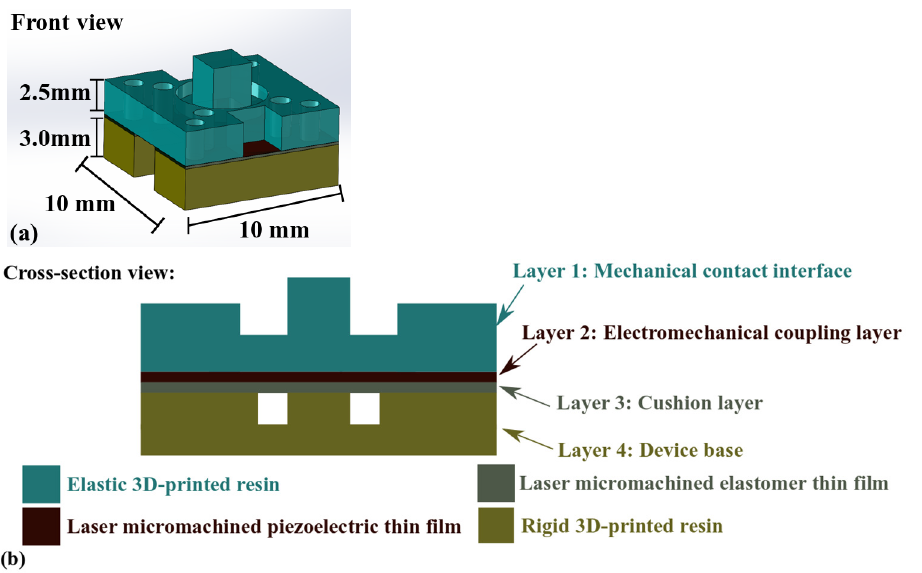
Figure 1. The general structure of the polymeric piezoelectric tactile sensor. ( a ) Front view, ( b ) Cross-section view.